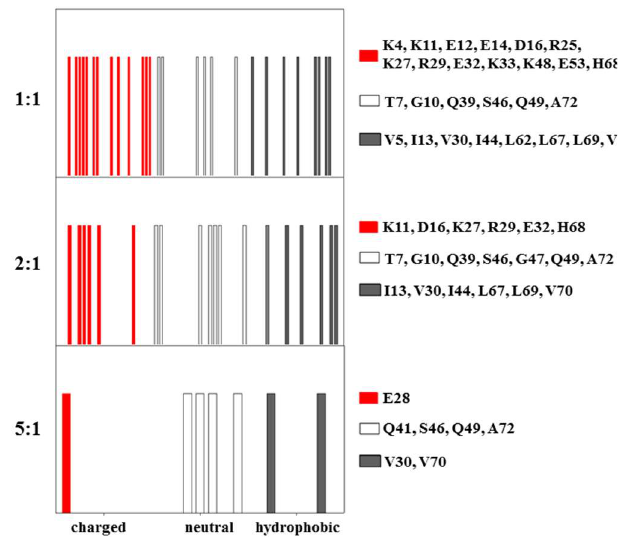
Figure 6. Flags reporting the residues of labeled NEDD8 that are perturbed in the 15 N HSQC NMR upon the interaction with unlabeled CUBAN. The molar ratios CUBAN:NEDD8 are 5:1, 2:1 and 1:1, respectively. Colors indicate perturbed residues with polar (red), neutral (empty) and hydrophobic (black) side chains respectively.